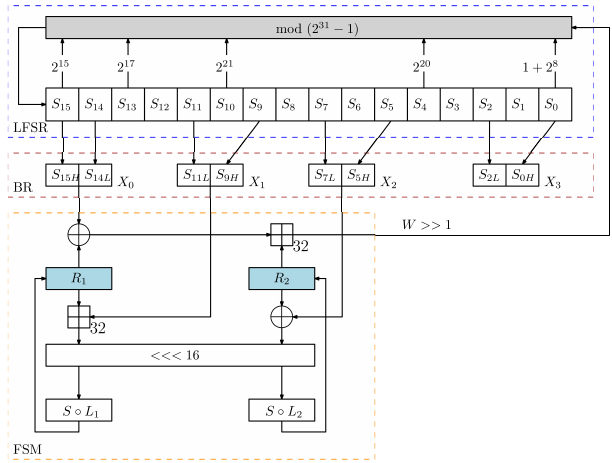
Figure 1: The initialization phase of